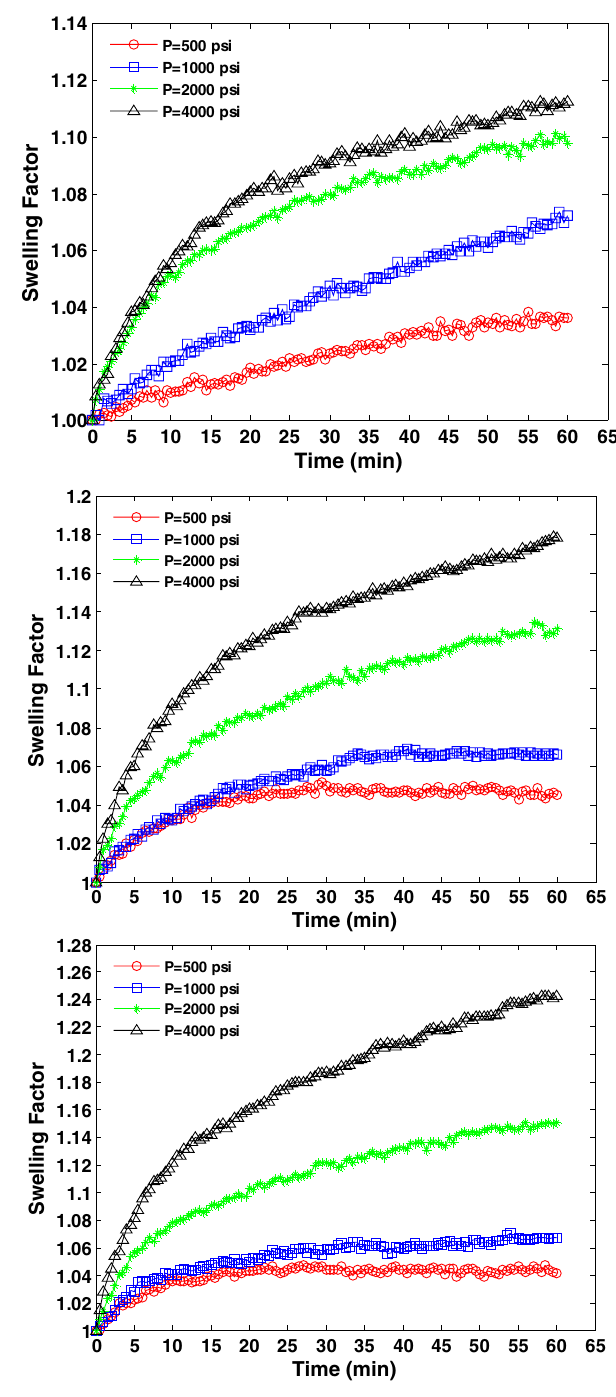
Fig. 2 Dynamic swelling factor of crude oil in the presence of 15,000 ppm of Na 2 SO 4 at temperature of a T = 30 °C, b 50 °C, and c 80